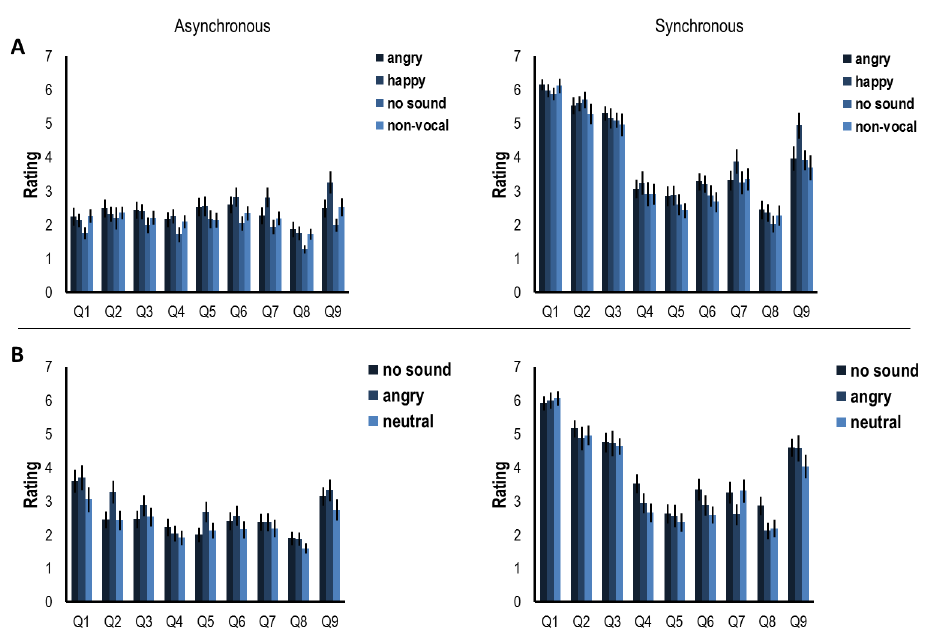
Fig 5. Average scores of the answers to the nine questions related to the subjective strength of the rubber hand illusion as measuredin experiment 1 (A) and 2 (B). Error bars indicate standarderror.